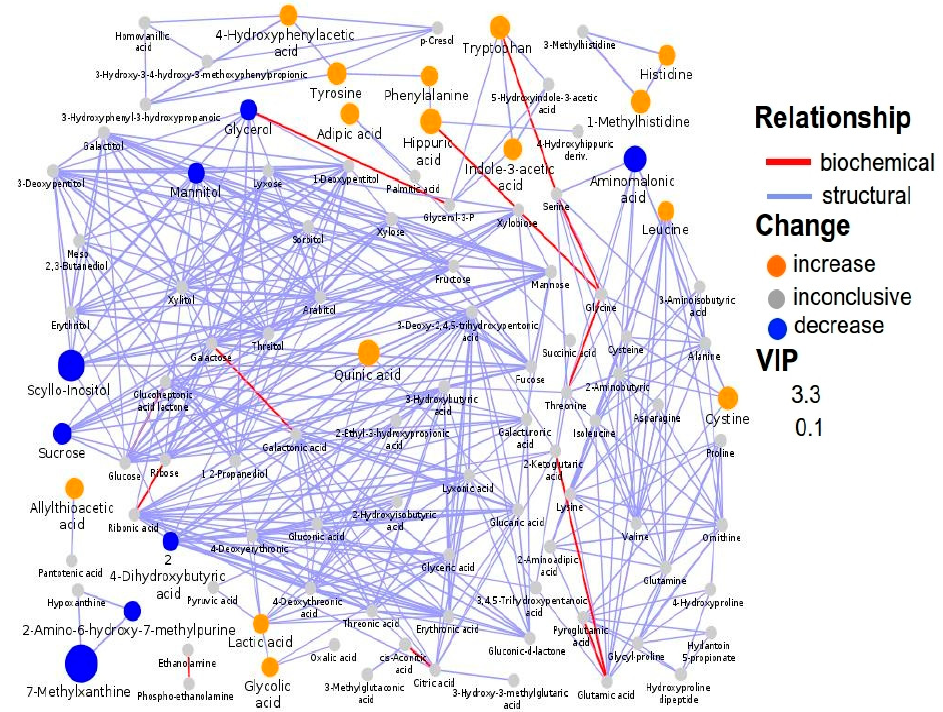
Figure 2. Biochemical network mapping resulting from the comparison between the urine metabolome of ASD children and that of NT children. Metabolites connections are based on biochemical (red edges) and structural (violet edges) similarities. Structural similarity is shown for Tanimoto coefficients ( ≥ 0.7, solid edges) and relaxed scores (dashed edges). Node size displays model VIP and color the direction of change in ASD relative to control samples.